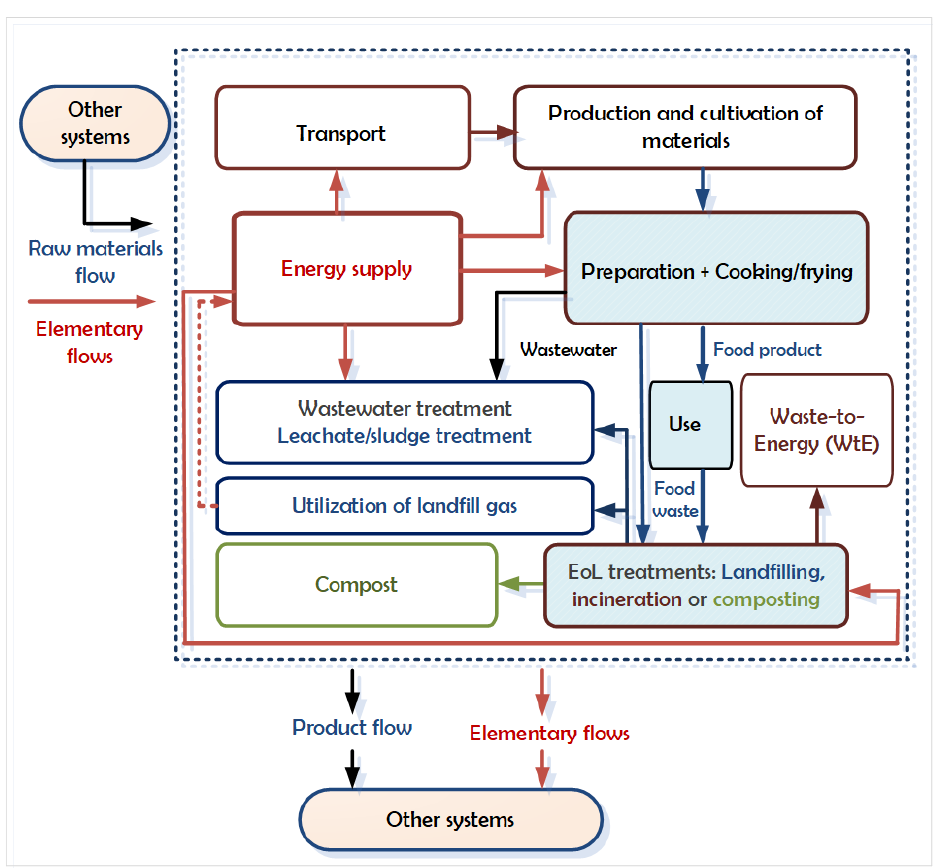
Figure 2. System boundaries for life cycle inventory (self-edited illustration).